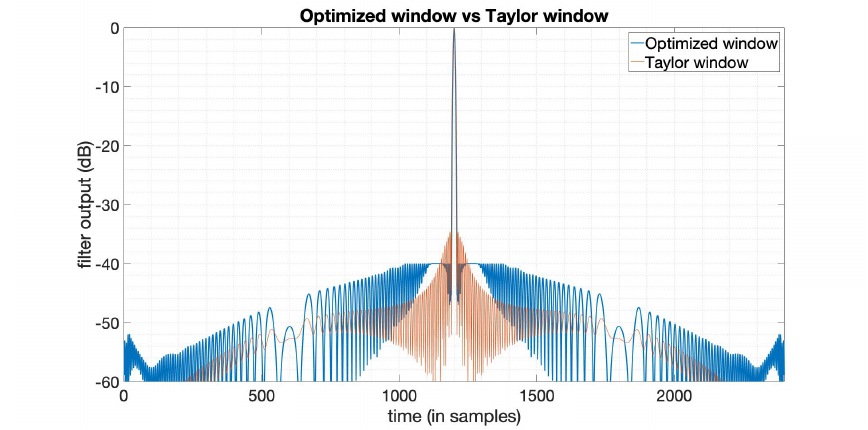
Figure 3. The output of the Taylor window (¯ n = 6,PSLR = − 35 dB) and the SNR loss-optimized